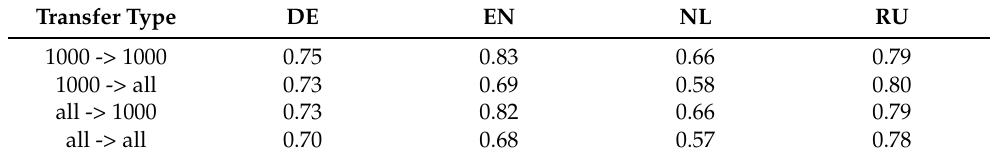
Table A5. Spearman’s correlation coefficients derived by MS-MiniLM model, transfer from Croatian.